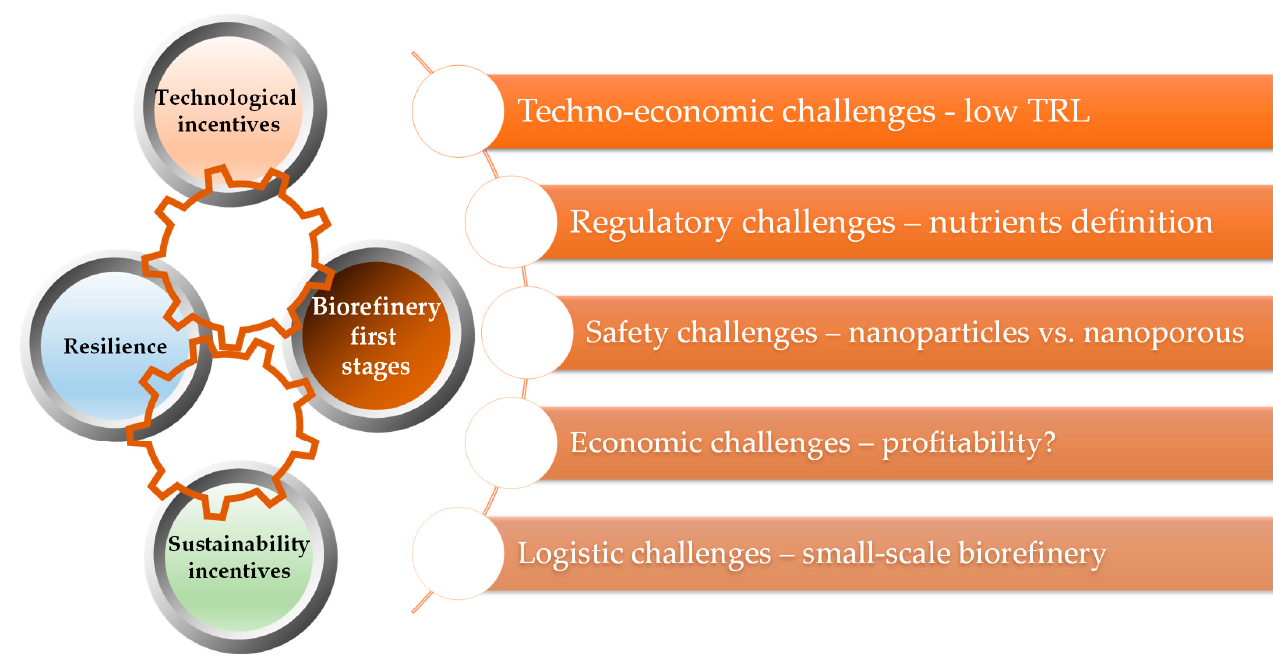
Figure 4. The incentives and challenges related to technologies that recover mineral nutrients in the first stages of the biorefinery processes.